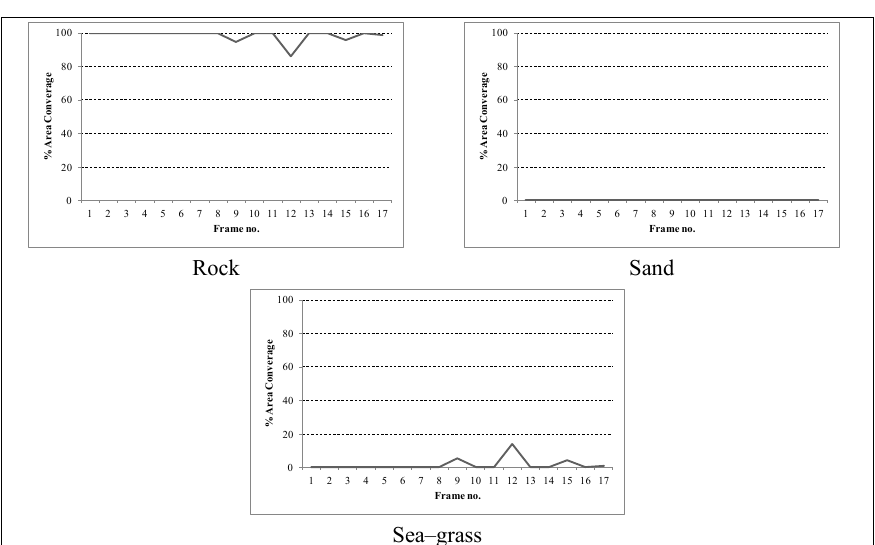
Fig. 8. Habitat map of Region